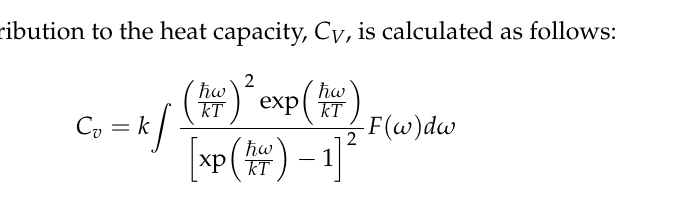
at a given temperature, t, is obtained by calculating the heat capacity, Equation (8), then inverting Equation (9) to obtain θ D .